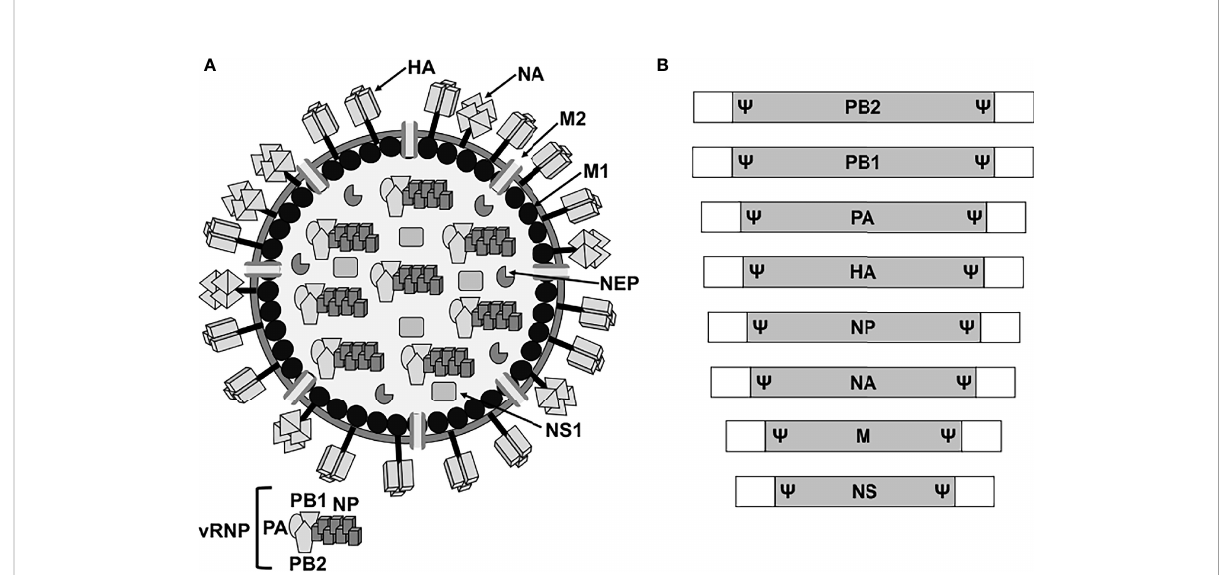
FIGURE 1 IAV virion structure and genome organization. (A) Virion structure. IAV particles have a lipid envelope where the two major viral glycoproteins HA and NA and the ion channel M2 are located. Below the viral lipid membrane is a layer composed of M1 protein and the NEP. Inside the viral particle are the vRNP particles formed by the vRNA coated by the viral NP and linked to the heterotrimeric polymerase complex (PB2, PB1 and PA). (B) Genome organization. IAV contains eight vRNA segments (PB2, PB1, PA, HA, NP, NA, M, and NS) made of a coding region (gray boxes) fl anked at the 3 ′ and 5 ′ terminal ends by untranslated non-coding regions (white boxes). At the end of the 3 ′ and 5 ′ coding regions are the speci fi c viral segment packaging signals ( Y ) required for ef fi cient encapsidation of the vRNP particles into new